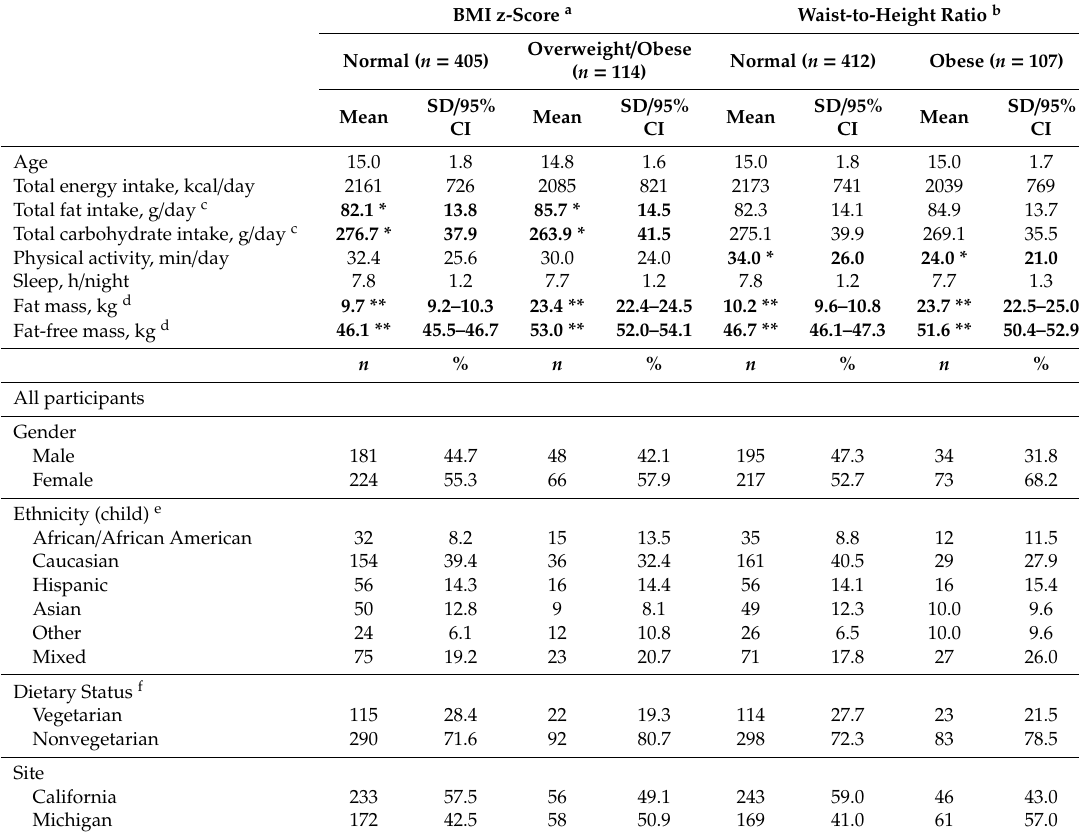
Table 2. Characteristics of participants according to categories of body weight and central